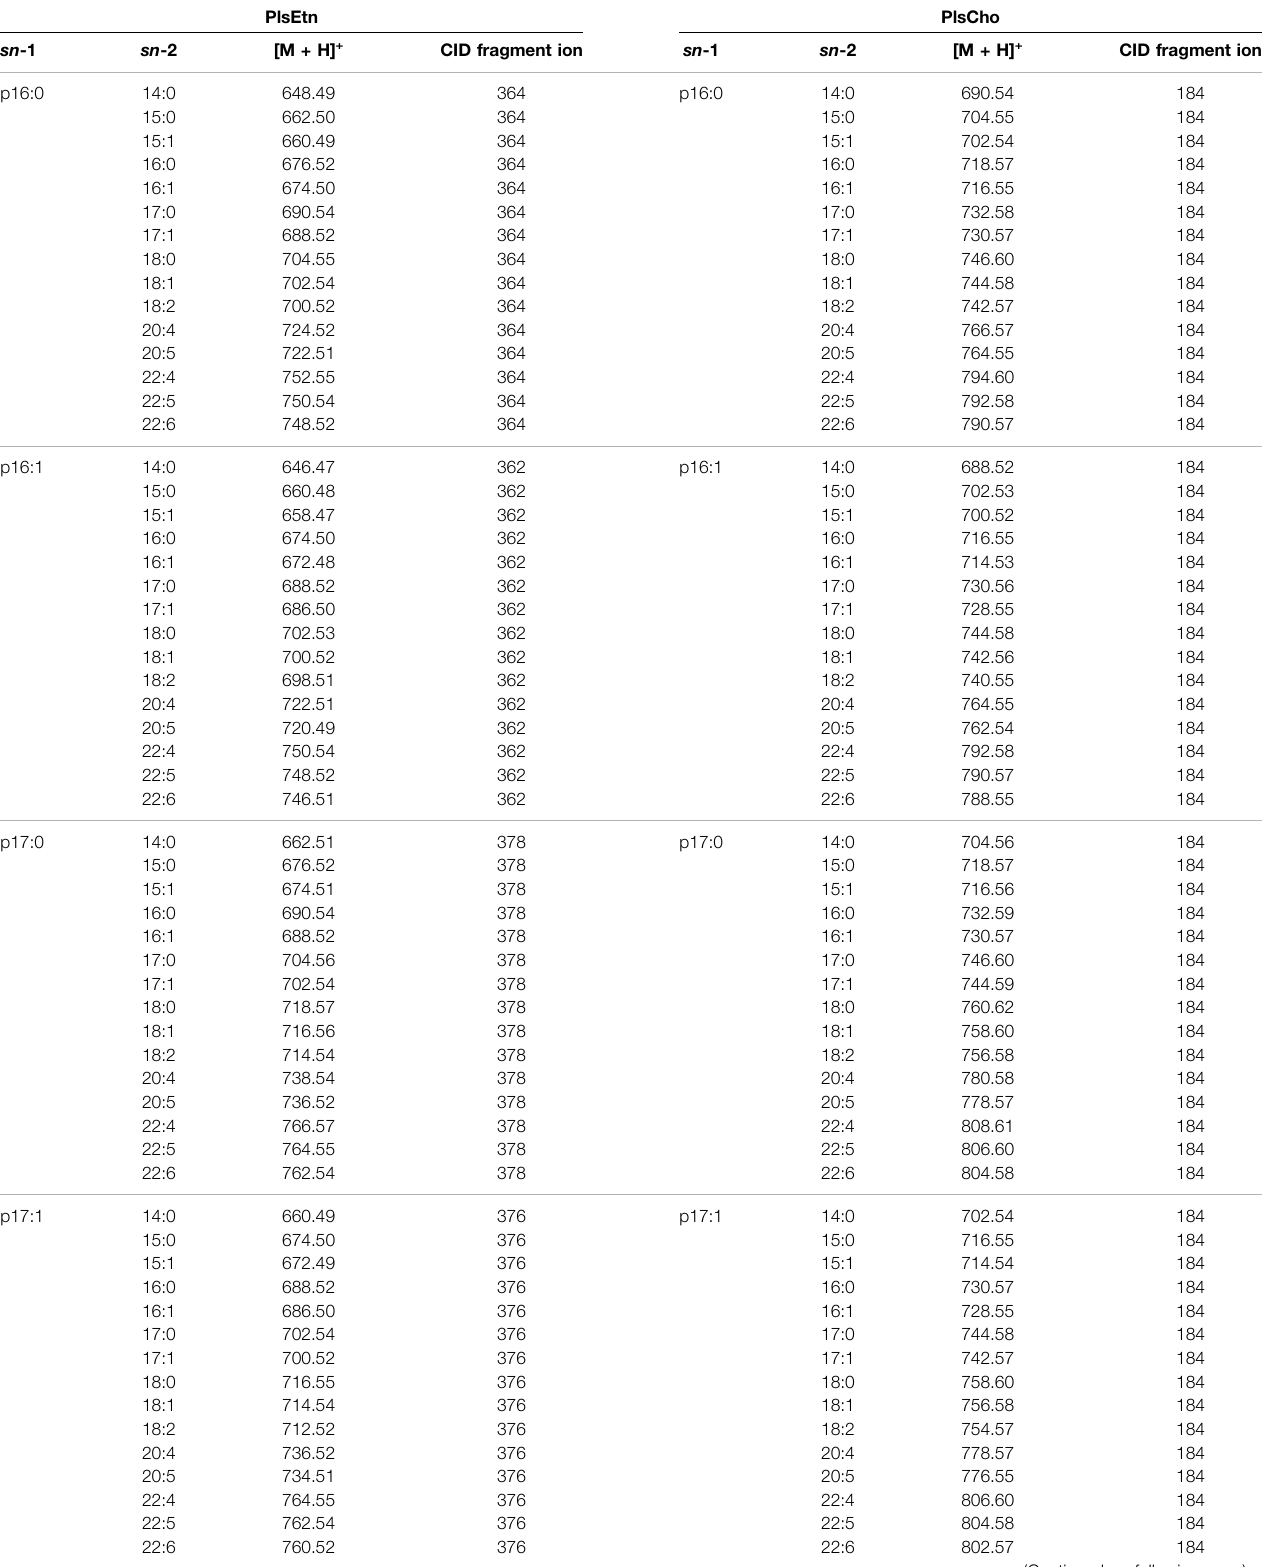
TABLE 1 | The parent and CID (collision induced dissociation) fragment ions of the measured plasmalogen molecular species. PlsEtn PlsCho sn -1 sn -2 [M + H]